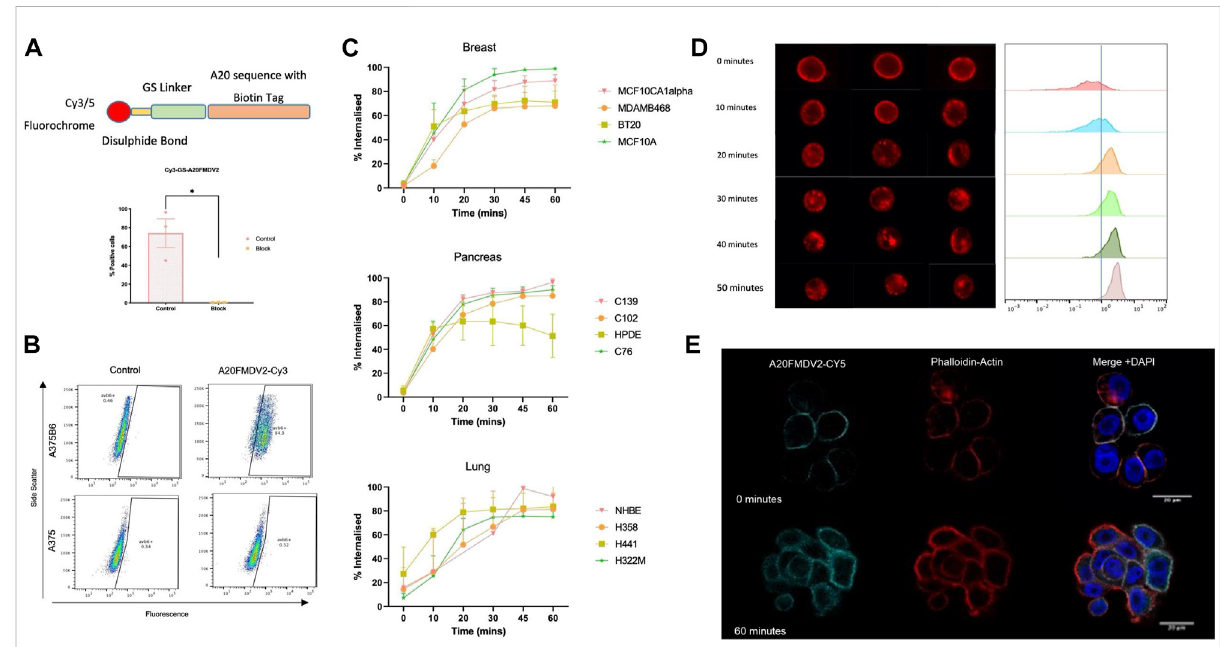
FIGURE 2 α v β 6bound A20FMDV2is internalised into cells over60 min. (A ,Top ) Design oftheCy3/5-SS-(GS) 5 -bioA20FMDV2 featuring adisulphide bond between the fl uorochrome and GS linker, to allow for cleavage of the fl uorochrome only. (Bottom) Pre-treating A375PB6 cells with α v β 6 speci fi c antibody 53A2 signi fi cantly reduced binding of Cy3-SS-(GS) 5 -bioA20FMDV2 (74.1 ± 26.4% to 0.44 ± 0.17%, p < 0.05), con fi rming it retained speci fi city.Datarepresentslivesinglecells,mean±SD, n =3,paired (B) A375PandA375PB6celllineswereexposedto100 nMofCy3-SS-(GS) 5 - bioA20FMDV2 peptide for 1 hour, and binding quanti fi ed by fl ow cytometry, using Cy3-bioA20ran to determine the non-speci fi c binding and gate the positive fraction. (C) Internalisation of Cy5-SS-(GS) 5 -bioA20FMDV2 was determined in a range of cell types of breast, pancreas and lung origin. Each panel consisted of both normal and cancer cell lines. No Signi fi cant differences were observed in the rate of internalisation between cell types. In each cell line, at least 50% of peptide was internalised in 30 min. (D) A20FMDV2 internalisation quanti fi cation using ImageStream fl ow cytometer. (Left)representativeimagesofcellsateachtimepointrevealingthatCy5-(GS) 5 -bioA20FMDV2isinternalisedfromthecellmembranefrom10 minof incubationat37 ° C.(Right)Quanti fi cationoftherelativeinternalisationshowsthattheproportionofCy5-(GS) 5